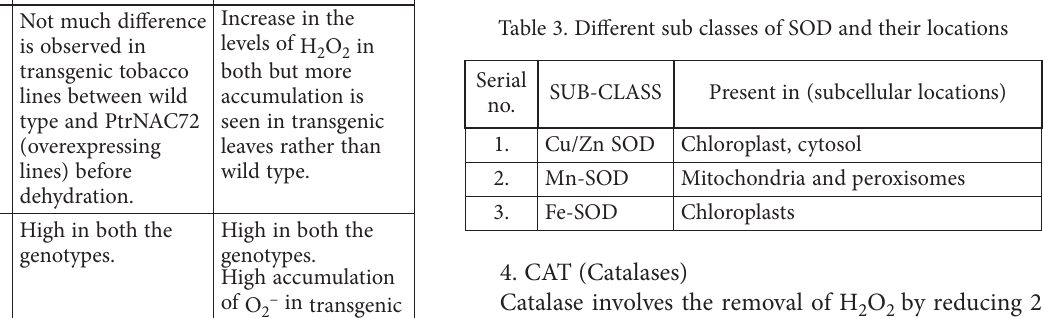
Table 2. Dehydration by histochemical staining was done with DAB (diaminobenzidine) and NBT (nitro blue tetrazolium) it shows blue coloration, it was done to examine the accumulation of 2 ROS species in the overexpression tobacco lines and NAC 72 mutant before and after the staining Serial